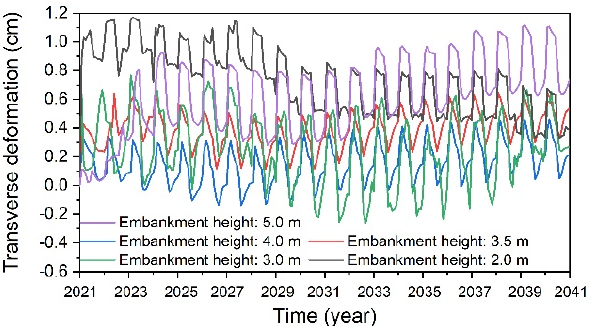
Figure 13. Curves of the variation in the transverse deformation difference between the shoulders and the road centerlines of different structures.